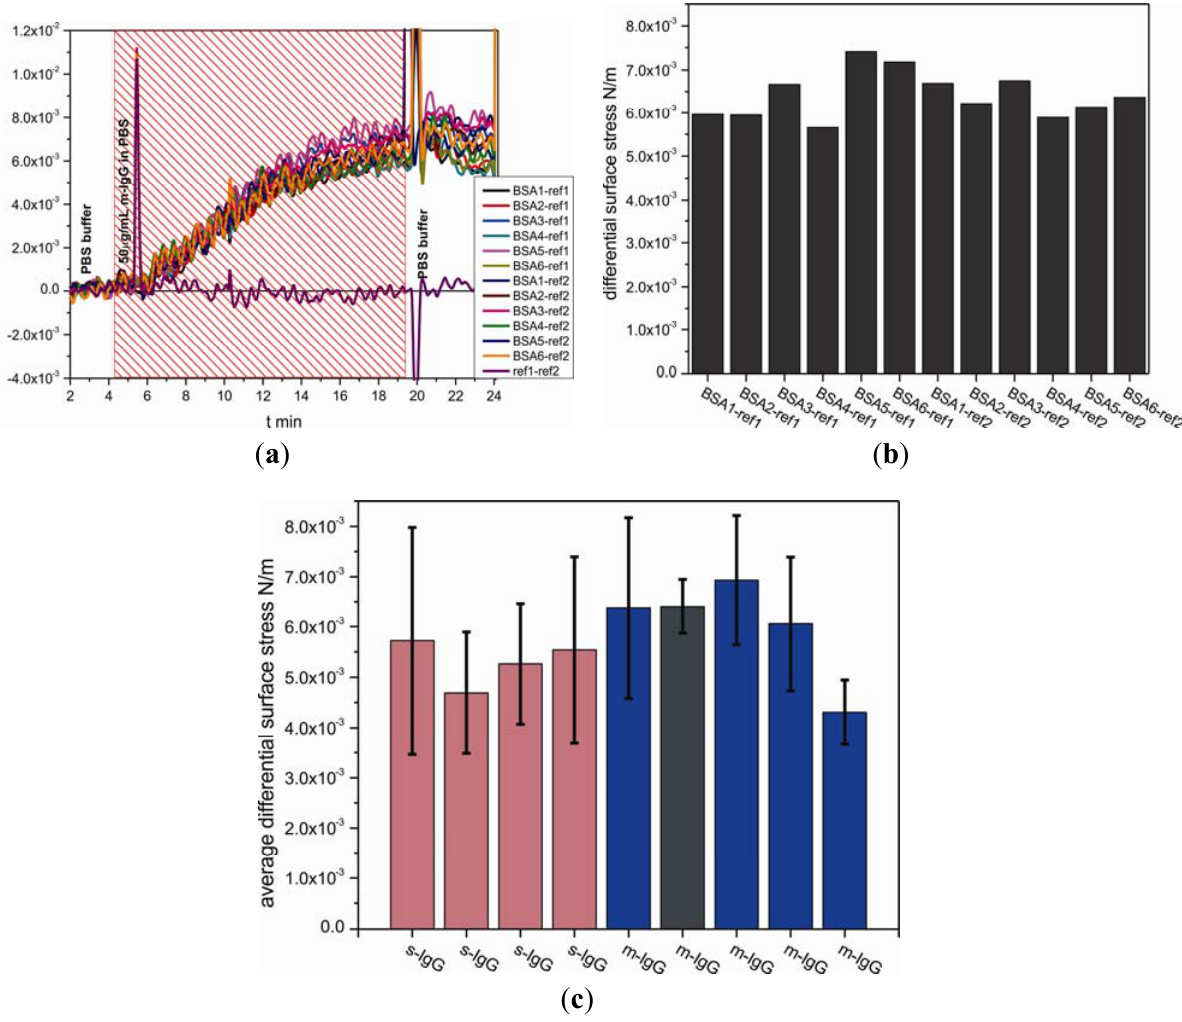
and robustness of the